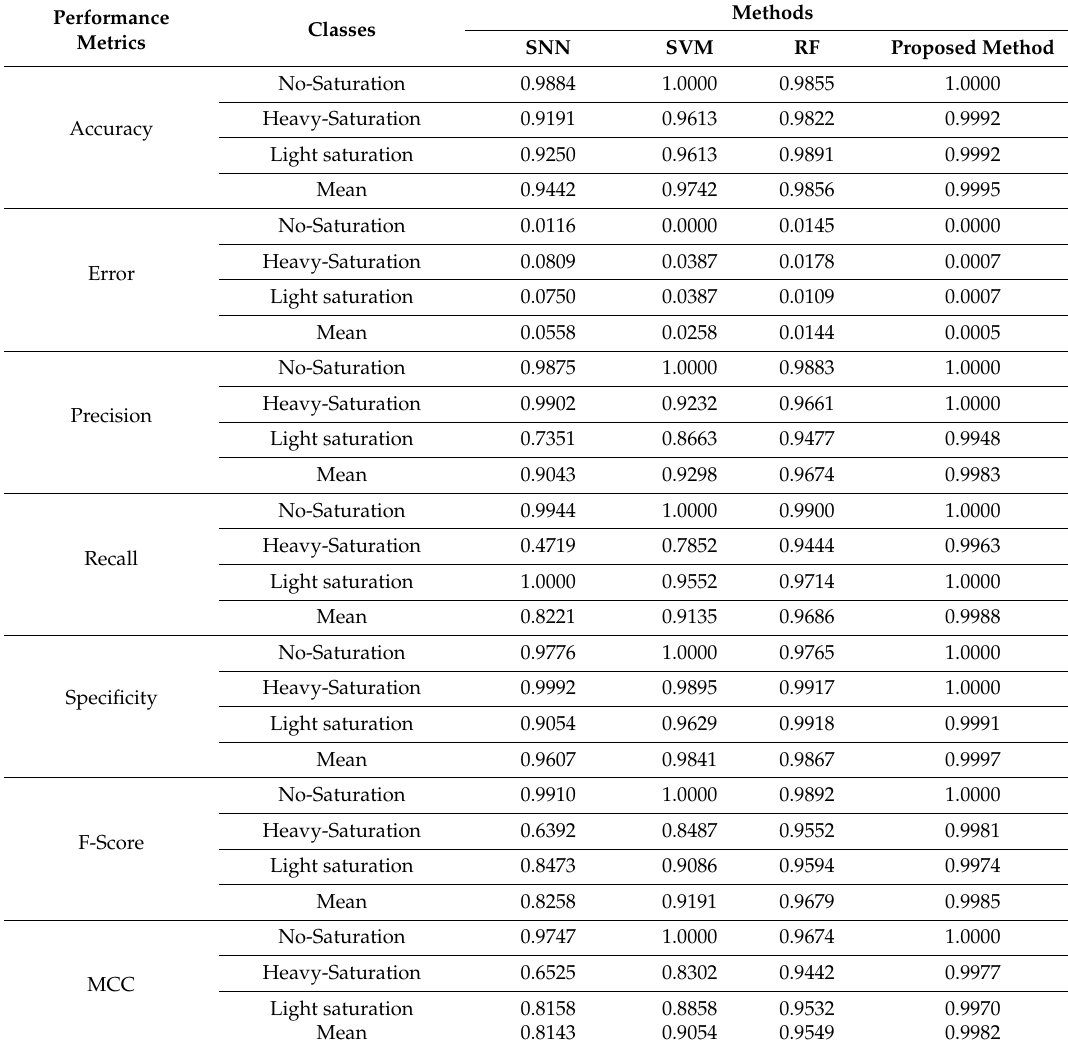
Table 13. Systematic analysis of different methods on each class of CT saturation. Classification performance is analyzed by taking the mean of each performance